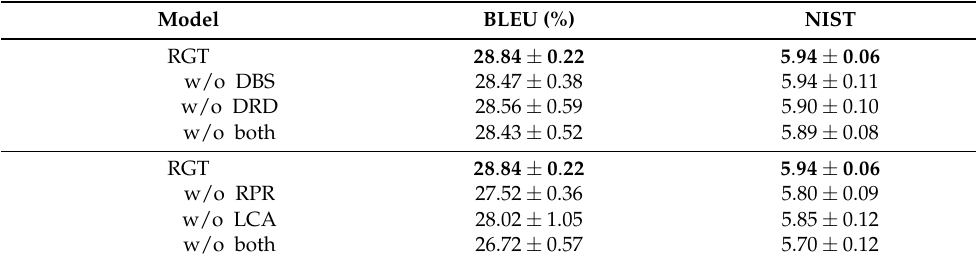
Table 6. Relation ablation. The upper part is to investigate relations among intermediate nodes and the lower is among leaf nodes. Bold means the best result.